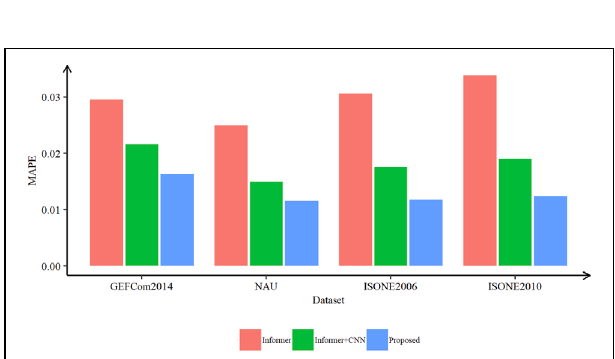
FIGURE 6 | Predict results of the ablation of the proposed model on the three data